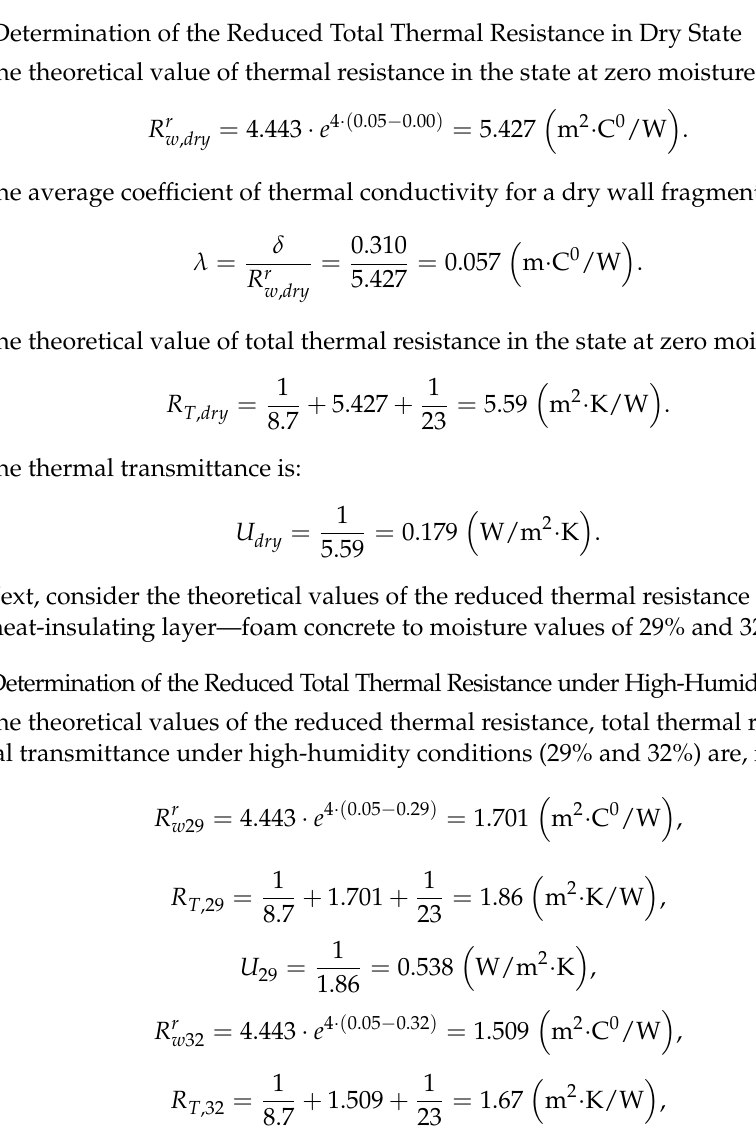
Figure 8. Separation of the working surface into material zones.